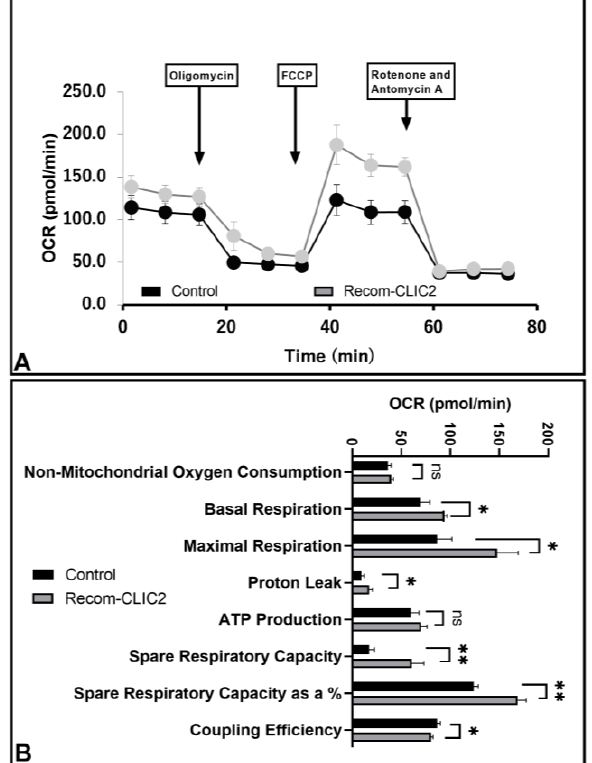
Figure 6. Modulatory effects of CLIC2 on the mitochondrial function in microglia. Recombinant CLIC2 exposure significantly enhanced mitochondrial function in primary cultured microglial cells. Mitochondrial oxygen consumption rate (OCR) ( A ) and mitochondrial extracellular acidification rate (ECAR) ( B ) were determined using a Seahorse XFp extracellular Flux Analyzer in microglia exposed to CLIC2 for 24 h. * p < 0.05 and ** p < 0.01 specify significant difference between the two groups